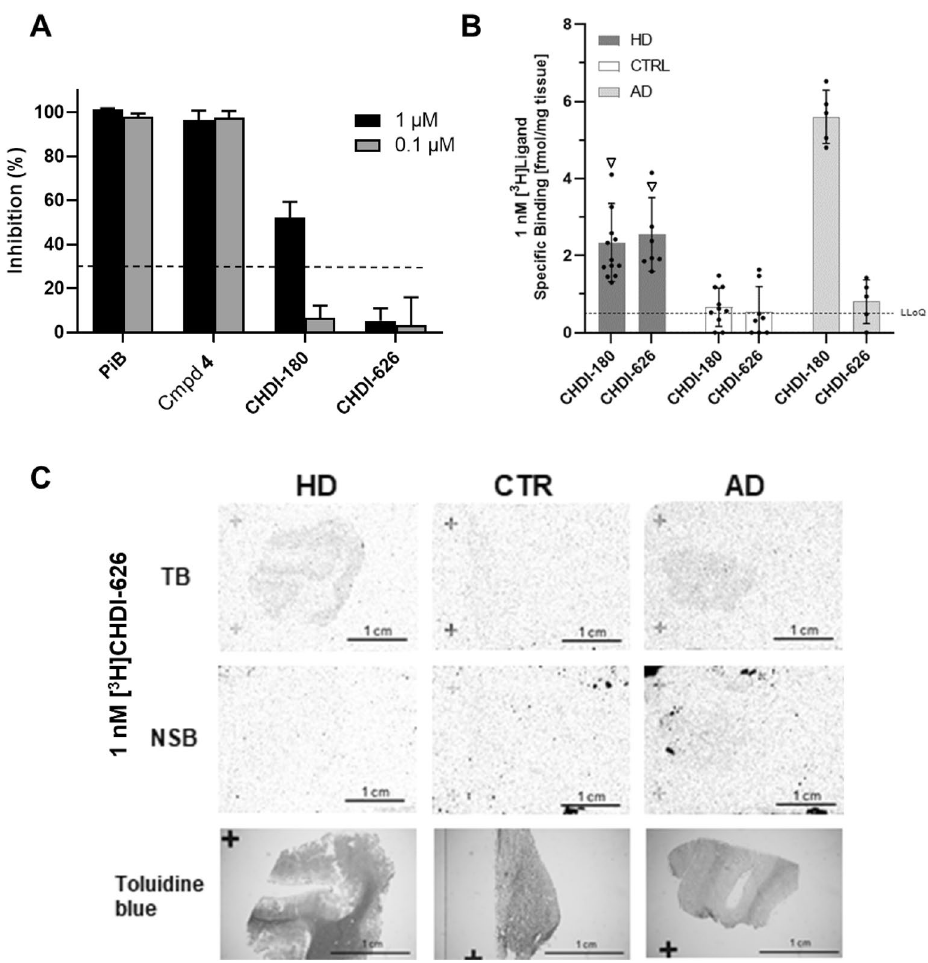
Figure 7. Reduced binding of CHDI-626 to human AD brain. ( A ) ADbh RBA. Competition format against 4 to determine inhibition of compounds at 1 µM and 0.1 µM, applied as counter assay; the dotted line at 30% inhibition indicates the threshold above which a compound is flagged as a potential beta amyloid binder. ( B ) Comparative ARG studies investigating ligand binding to human HD, AD and CTRL brain sections. Total (TB) and non-specific (NSB) of [ 3 H]CHDI-180 and [ 3 H]CHDI-626 to human brain sections in ARG. Black circles indicate binding to individual adult HD brains, the white triangle depicts binding to one juvenile HD case. Data shown as Median ± interquartile range. Statistical analysis by Mann–Whitney test, two-tailed, 95% confidence level. LLoQ: lower limit of quantification ( C ) Representative images of [ 3 H]CHDI-626 total binding (TB) and non-specific binding (NSB) in human HD, AD and CTRL brain sections. Toluidine blue staining was used to discriminate white matter (dark gray) and gray matter (light gray) in the same section used for